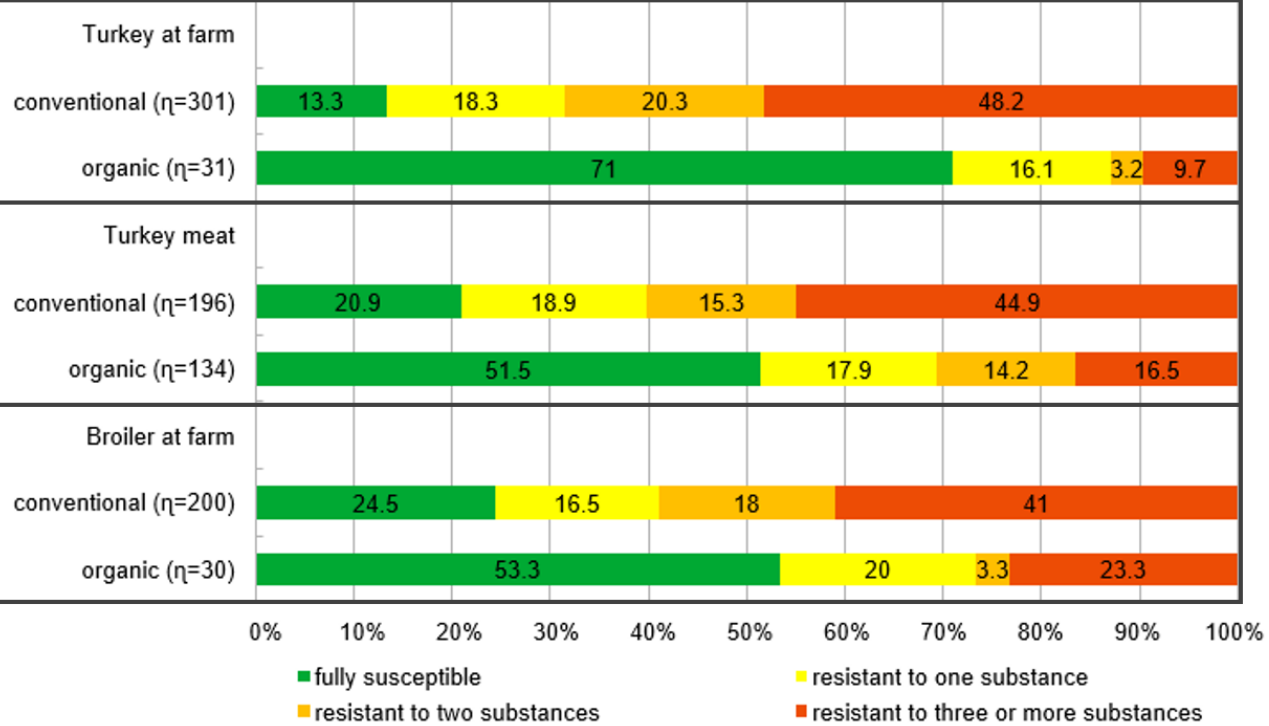
Figure 1. Percentage of isolates from the different categories fully susceptible, or resistant to one, two, or three or more classes of antimicrobial substances ( n = number of isolates tested).